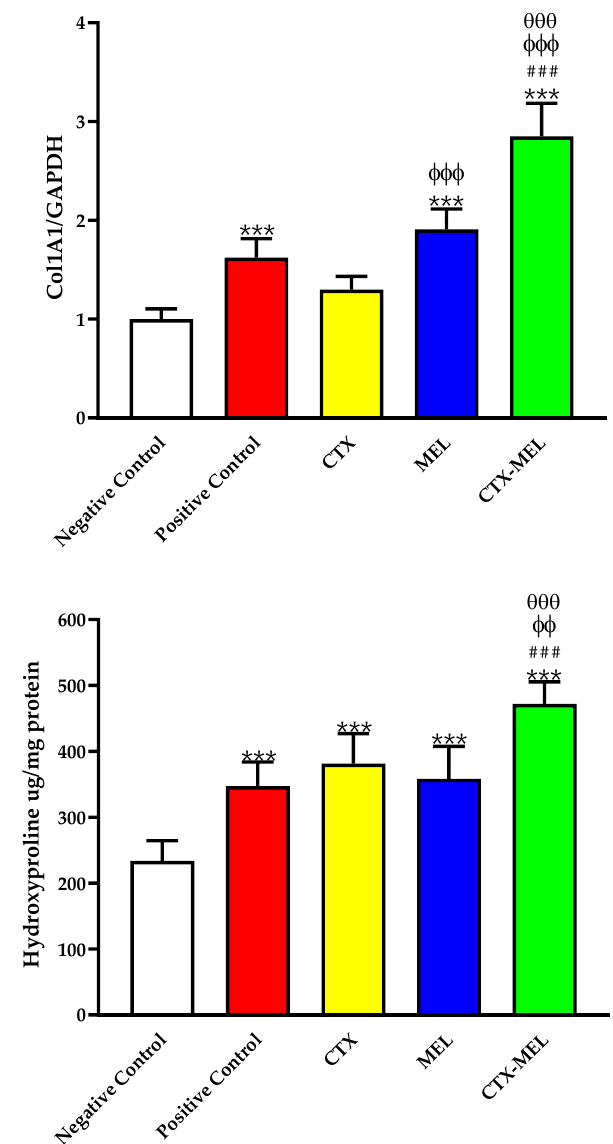
Figure 6. Effect of CTX, MEL, or CTX – MEL nanocomplex on mRNA expression of ( A ) Col1A1 and ( B ) hydroxyproline content at day 14. The abundance of Col1A1 mRNA is expressed relative to the abundance of GAPDH mRNA. Negative control refers to rats that received topical plain vehicle consisting of HPMC-based hydrogel (1.5% w / v ) on the wound area, while positive control refers to animals that received 0.5 g of Mebo TM ointment on the wound area. Data are expressed as mean ( n = 6) ± SD. *** Significantly different vs. negative control, p < 0.001; ### significantly different vs. positive control, p < 0.001; φφ significantly different vs. CTX, p < 0.01; φφφ significantly different vs. CTX, p < 0.001; θθθ significantly different vs. CTX, p <